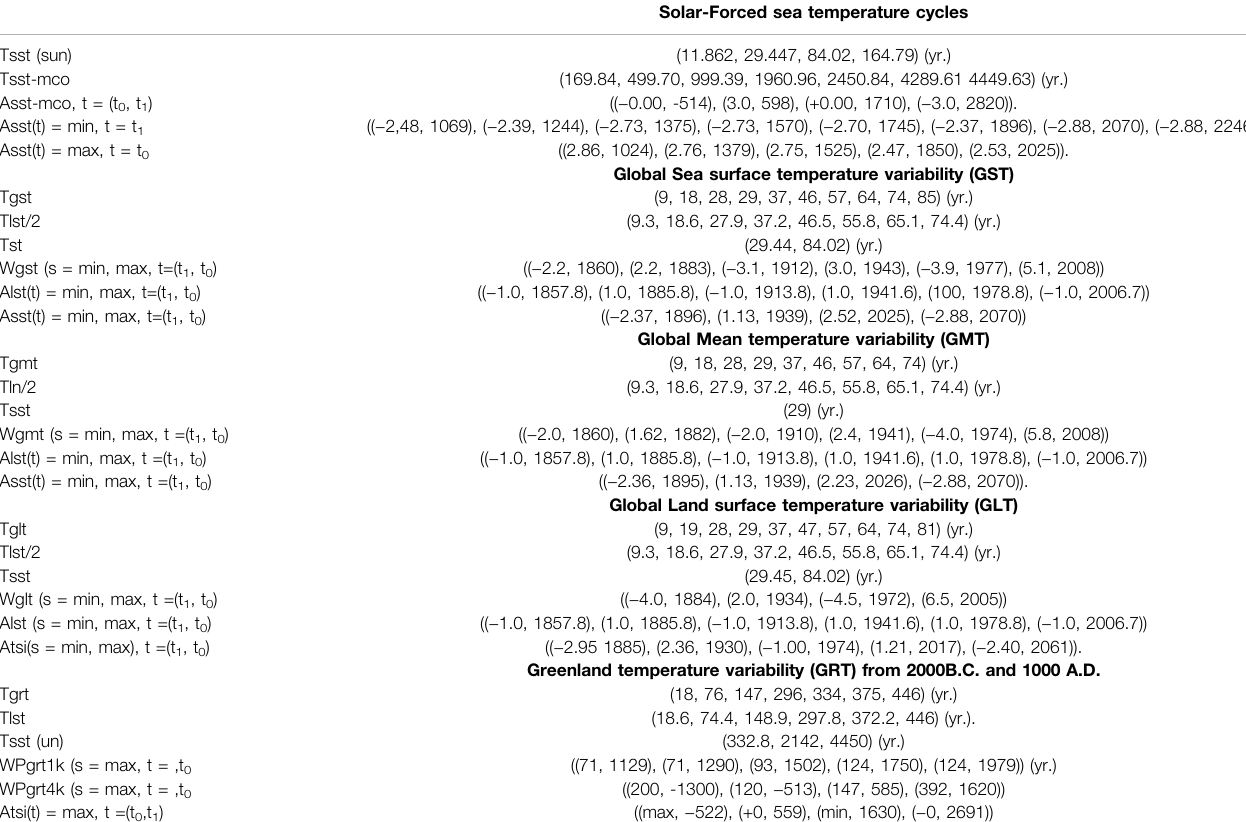
TABLE 2 | Cycle- and phase-coincidences between stationary solar-forced sea temperature cycles (GST), global sea surface temperature cycles (GST), global mean temperature cycles (GMT), global land temperature cycles (GLT) and Greenland temperature cycles (GRT). Solar-Forced sea temperature